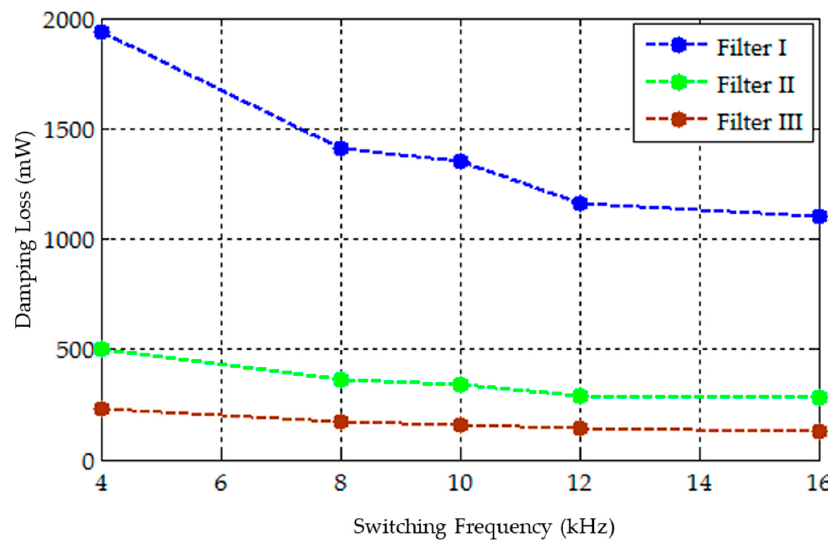
Figure 5. Damping loss with switching frequency variation.